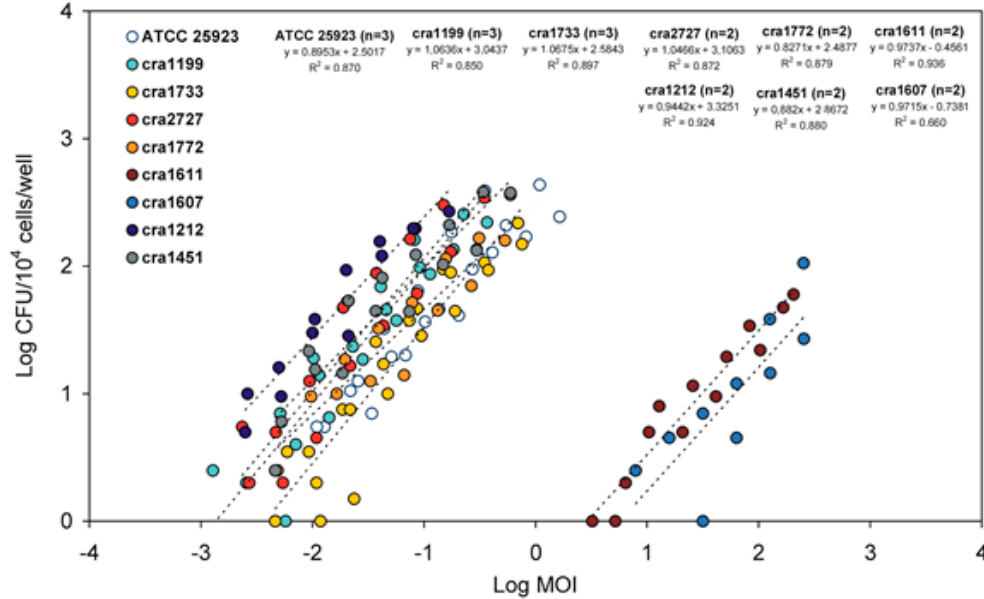
Figure 5. Correlation of internalised CFU vs. MOI. This dispersion plot based on a logarithmic scale shows the first-order linear regression curves obtained for each of the nine S. aureus strains. Per each strain, the number of experiments performed, the equation of the regression curve and the R-square value are reported. For S. aureus strain cra1199, only the three experiments performed on the low scale of MOI are plotted. When including the additional two experiments performed for cra1199 on the top of the scale of MOI, the R-square was found to increase from the value reported here of 0.85 to 0.97.